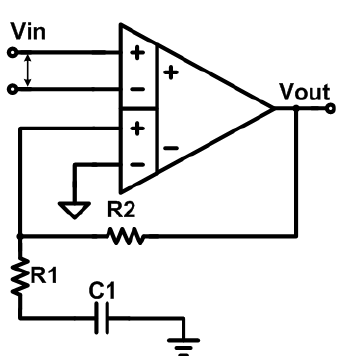
Figure 6. DDA circuit.